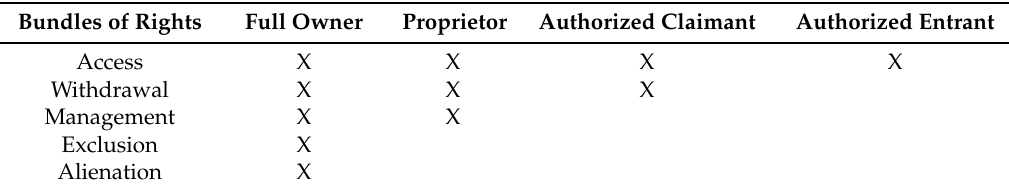
Table 1. Bundles of Rights Associated with Land Ownership. Source: [51].